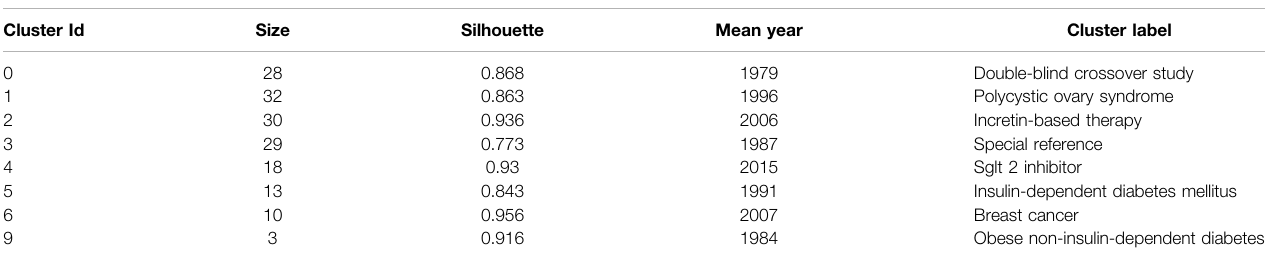
TABLE 5 | The detailed information of the 8 clusters in Figure 7 .